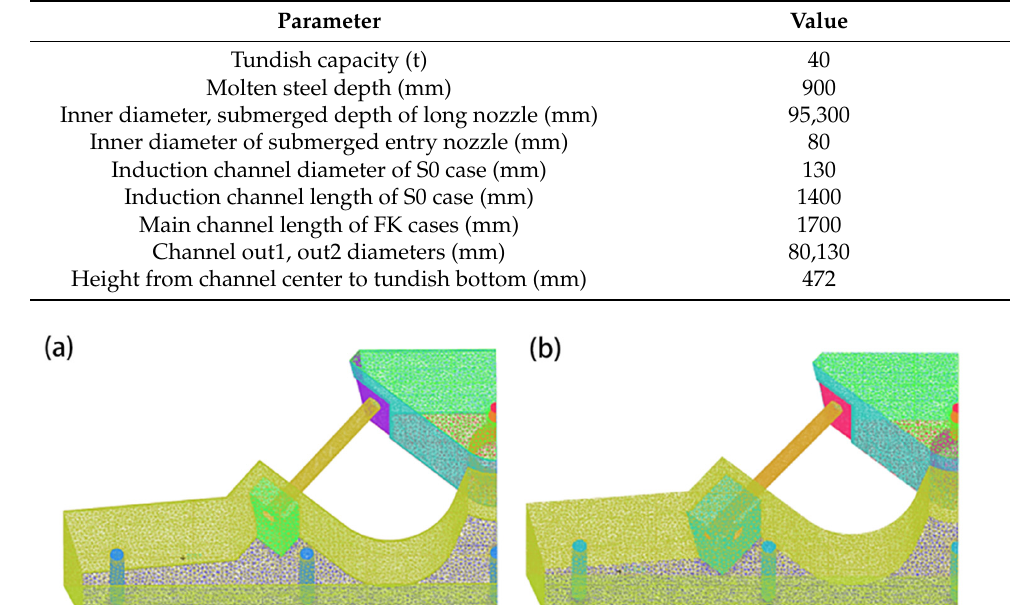
Table 1. Geometrical sizes of the tundish with induction heating channel.